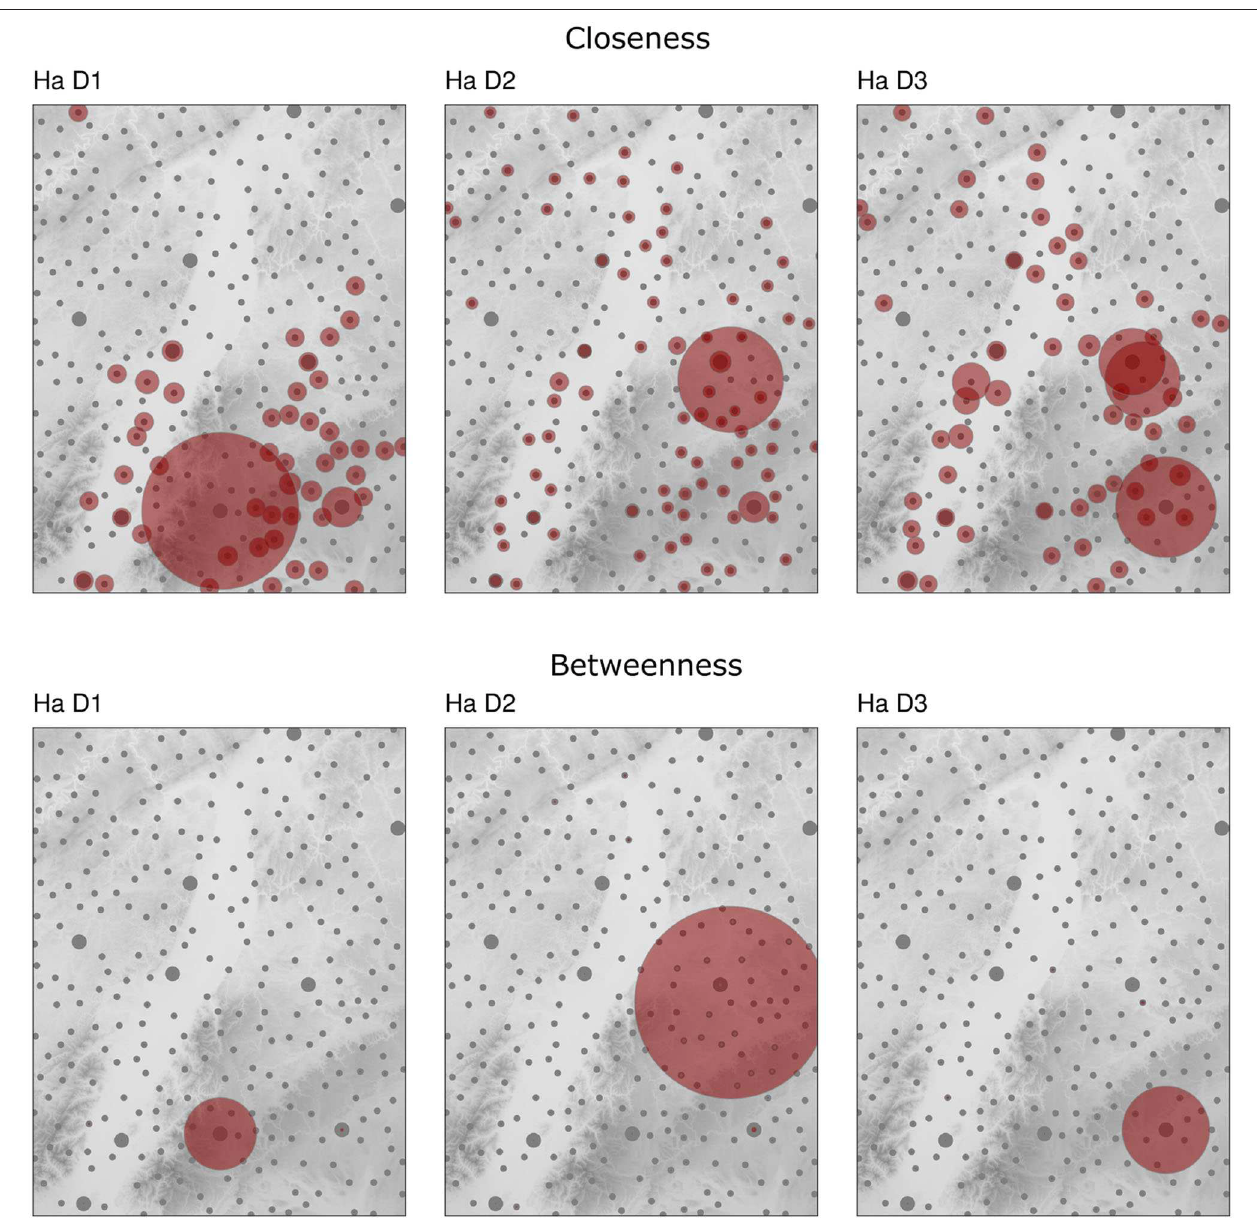
FIGURE 3 | Closeness and betweenness of full weighted graphs. Gray points are the simulated sites and the Princely Seats, the red circles indicate the centrality according to the mentioned index, where the size of the circles corresponds with the centrality. The symbols of each row is scaled